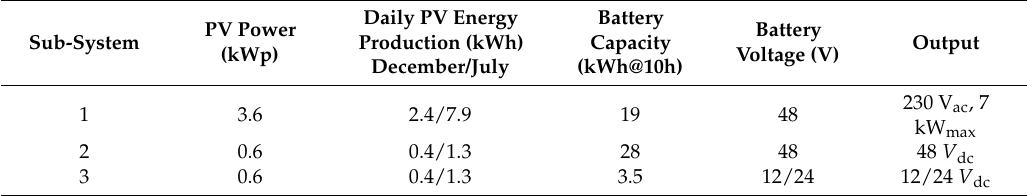
Table 3. Characteristics of the three independent stand-alone